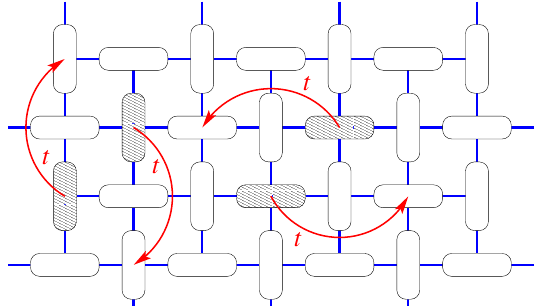
Figure 6: A schematic representation of the correlated hopping of two triplons, which are placed on two next-nearest-neighbor dimers. Arrows indicate the possible hop- pings of triplons within a